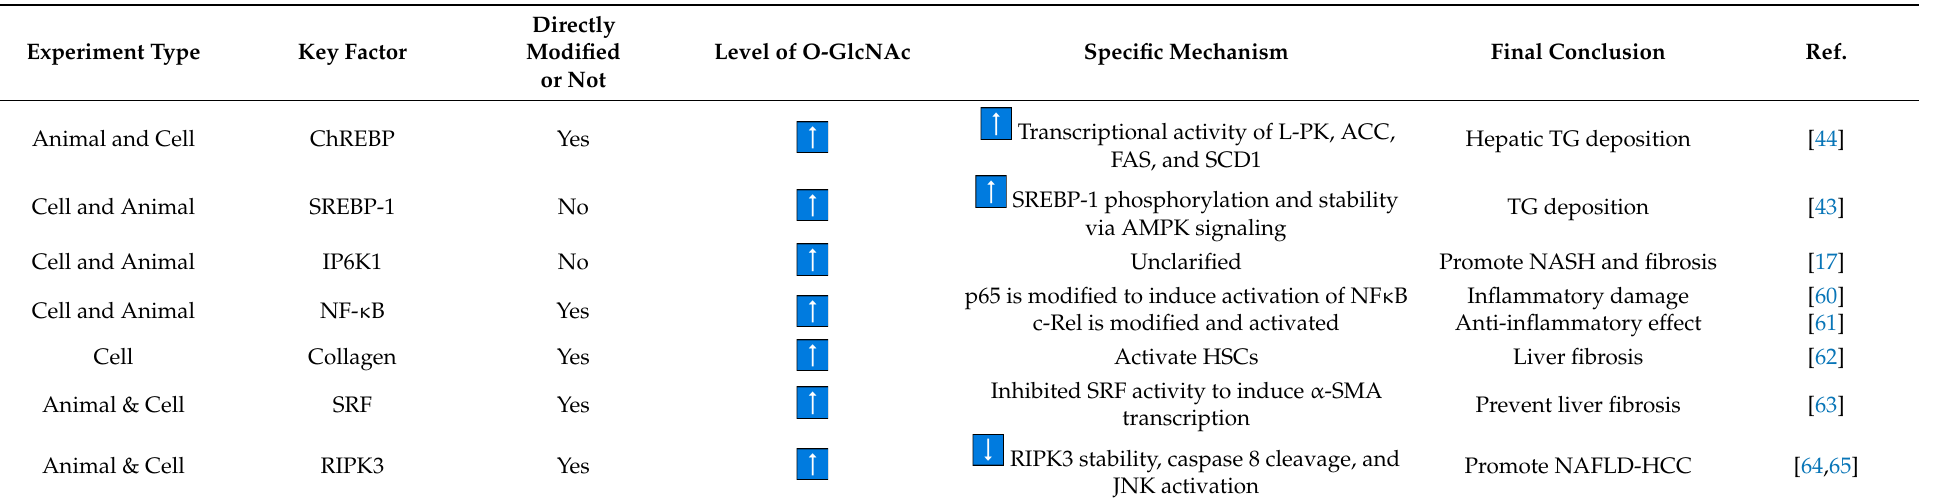
Table 1. Role of O-GlcNAc on the process of